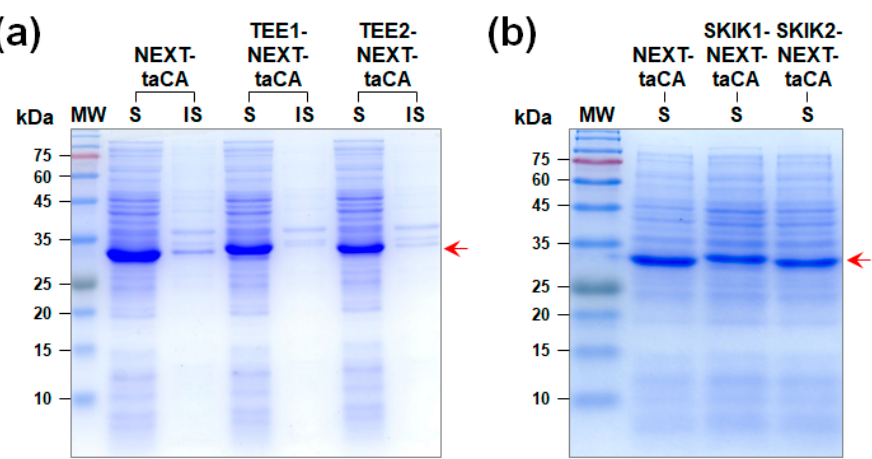
Figure 1. Expression of NEXT-taCA fused with ( a ) the translation-enhancing element (TEE) or ( b ) the SKIK tag analyzed by SDS-PAGE followed by Coomassie blue staining. The arrow indicates the band positions of recombinant proteins. Lanes: MW, molecular mass marker; S, soluble fraction; IS, insoluble fraction.